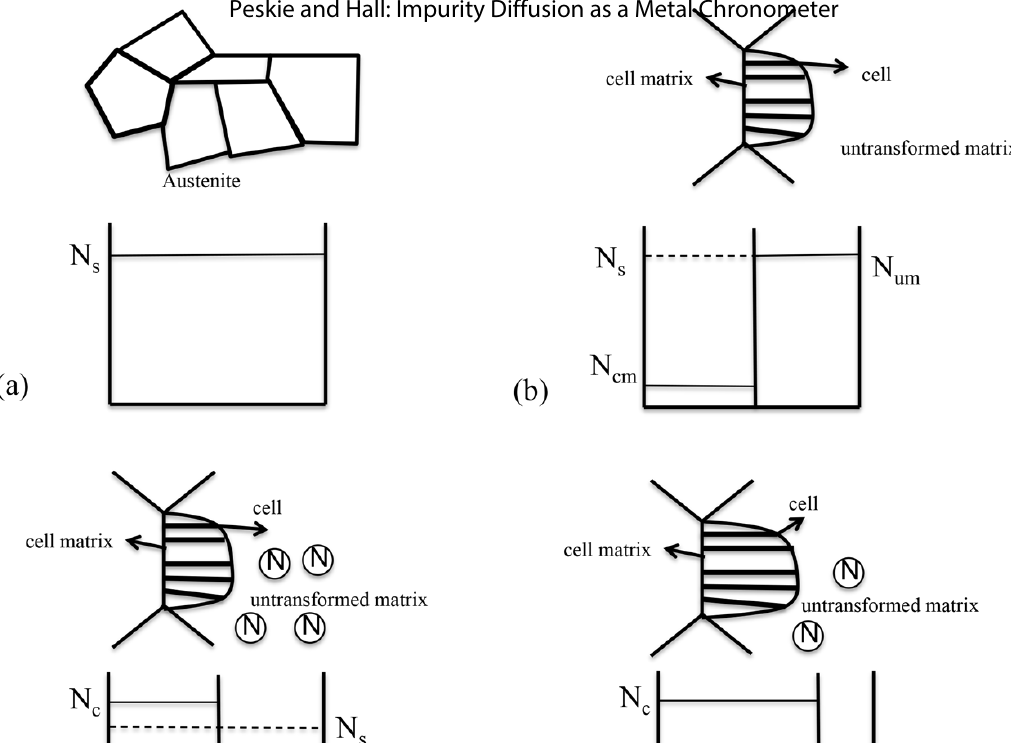
Figure 3. Growth mechanism for DP in the multi-component system (Fe-Cr-Mn-N). (a) nitrogen concentration in solution- treated samples; (b) formation of cells after aging at t=t 1 ; (c) nitrogen diffusion at t=t 2 ;(d) termination of cell growth at t=t 3 . [ 20 ]